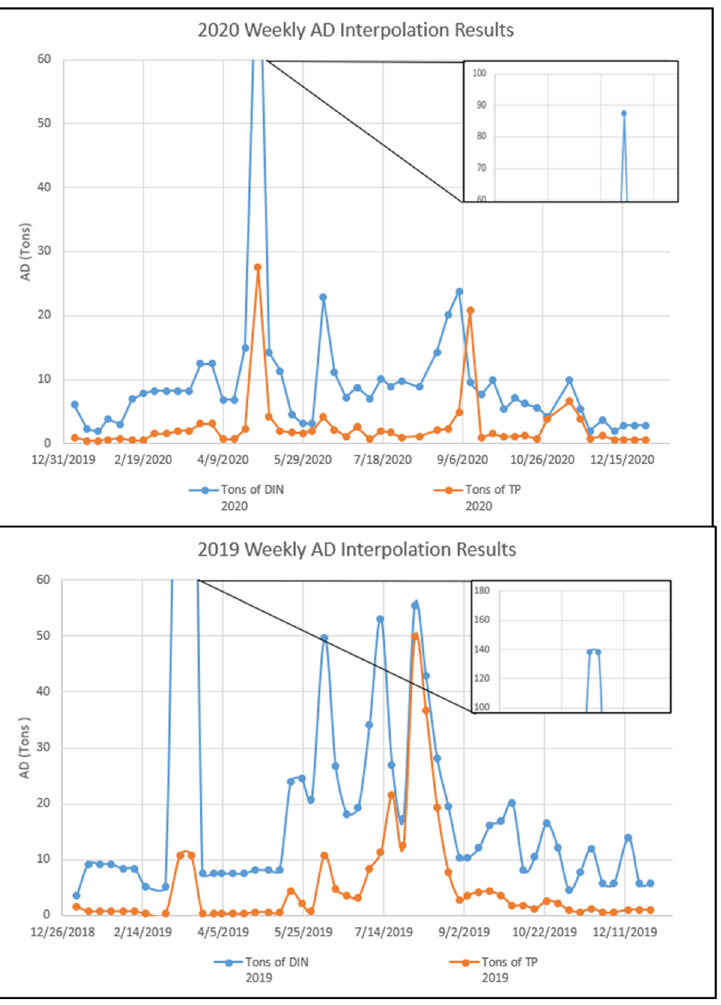
Figure 15. Weekly for DIN and TP AD for 2020 and 2019 in the top and bottom panels, respec-